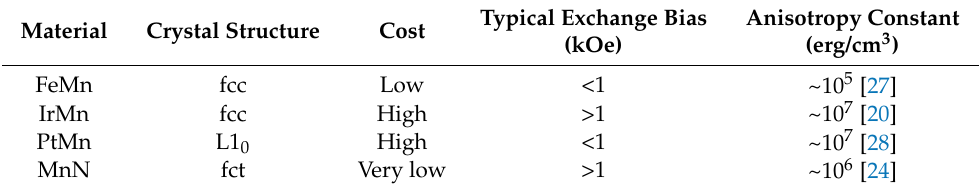
Table 1. Summary of the main properties of Mn-based AF